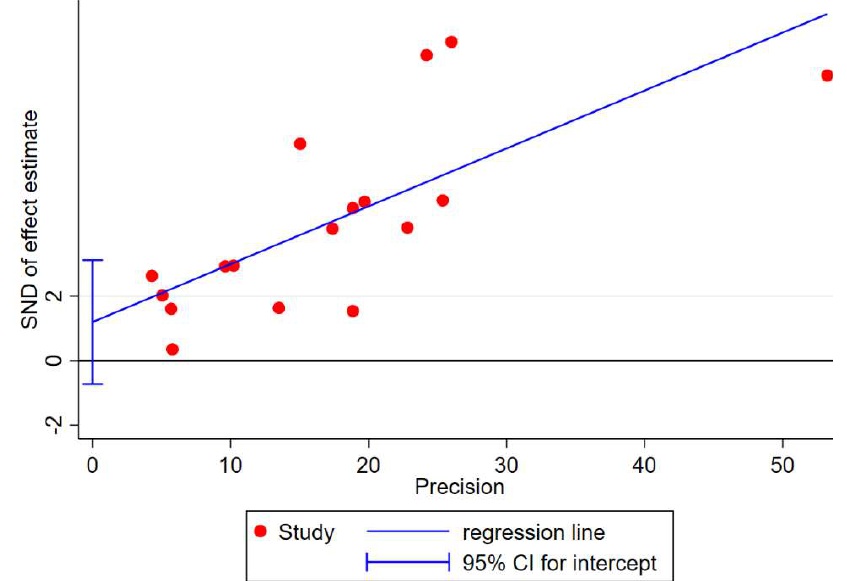
Figure 4. Egger’s test of studies evaluating potential publication bias.